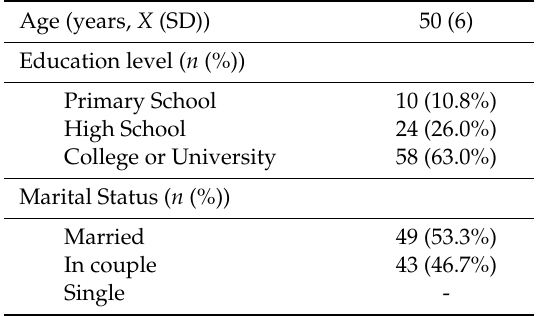
Table 7. Baseline characteristics of women for responsiveness (N =